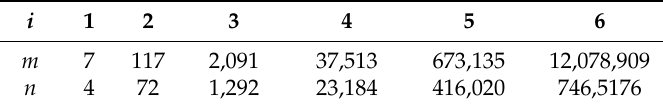
Table 1. Recursive solutions to the Diophantine